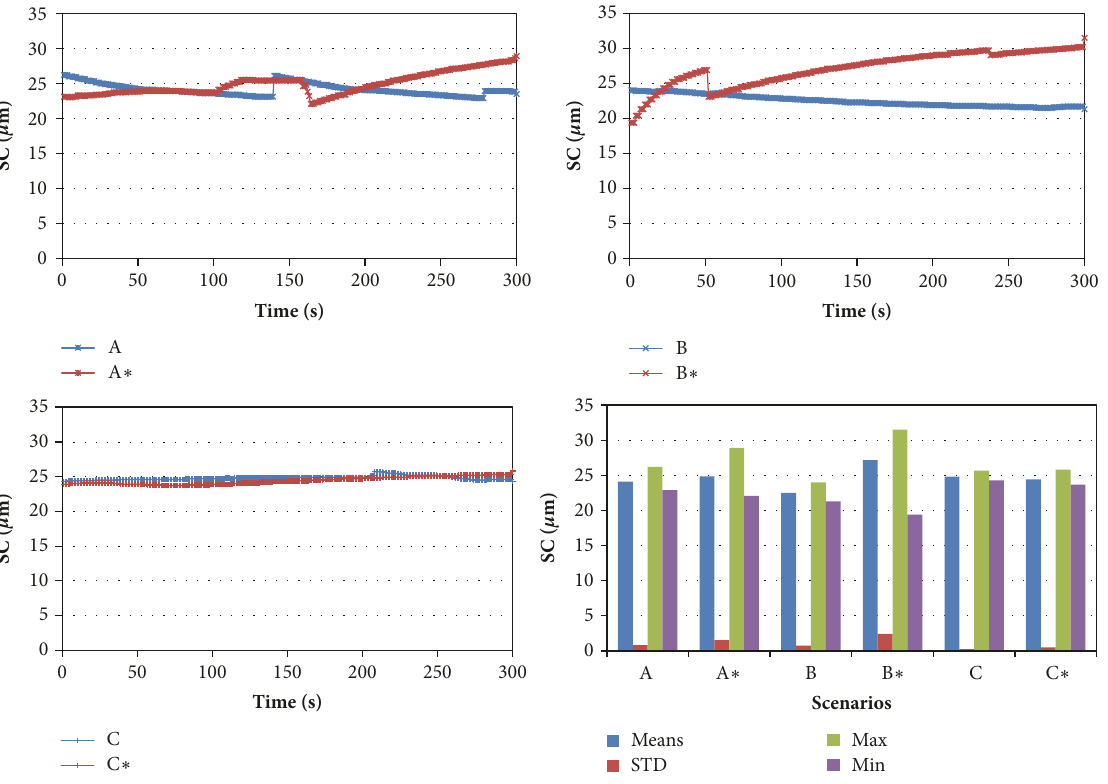
Figure 7: The value of SC in different scenarios.